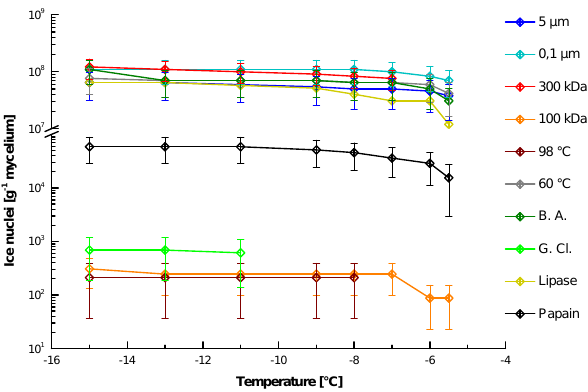
Figure 4. Number of IN per gram of mycelium for isolate ID6 after filtration, thermal, chemical, or enzymatic treatments. G. Cl stands for guanidinium chloride and B. A for boric acid. Error bars repre- sent the 95% confidence